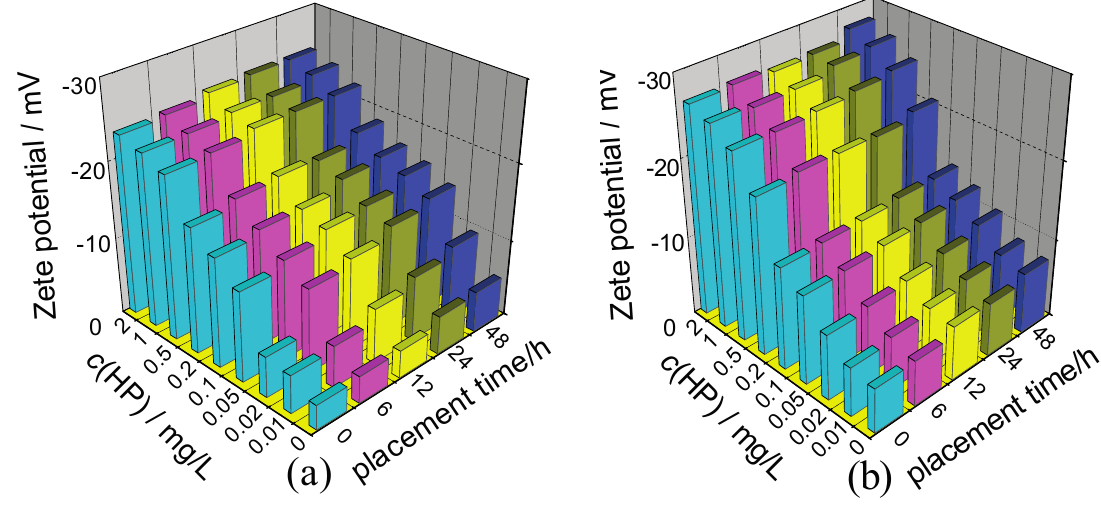
Figure 3. Effect of c (HP) and placement time ( t ) on Zeta potential of nano COM and nano COD crystals. ( a ) nano COM; ( b ) nano COD. Ion concentration: 0.15 mmol·L − 1